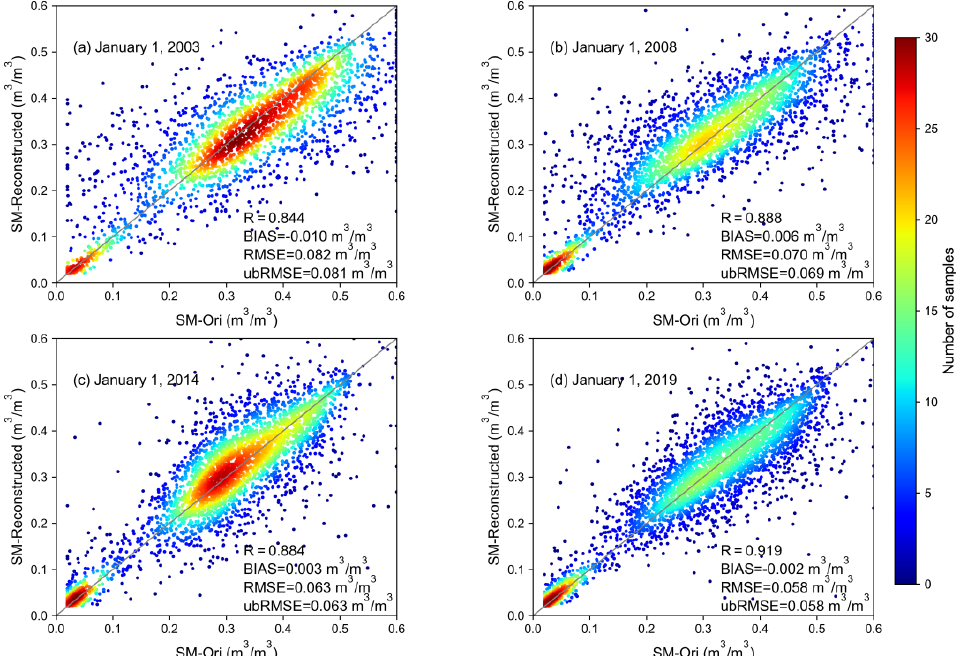
Figure 10. Scatterplots of the reconstructed surface soil moisture against and original values over the sub-regions on 1 January of 2003, 2008, 2014 and 2019. Note: the color density indicates the number of samples .